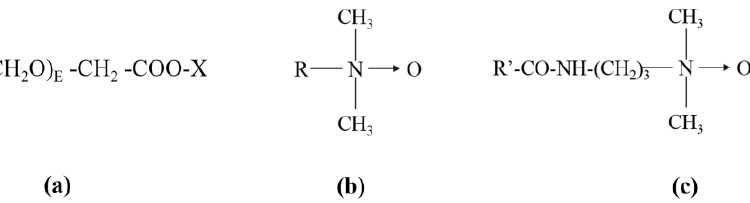
Figure 1. Molecular structure ( a ) ether carboxylic derivative surfactants, EC-R 8 E 8 , EC-R 12–14 E 3 , EC-